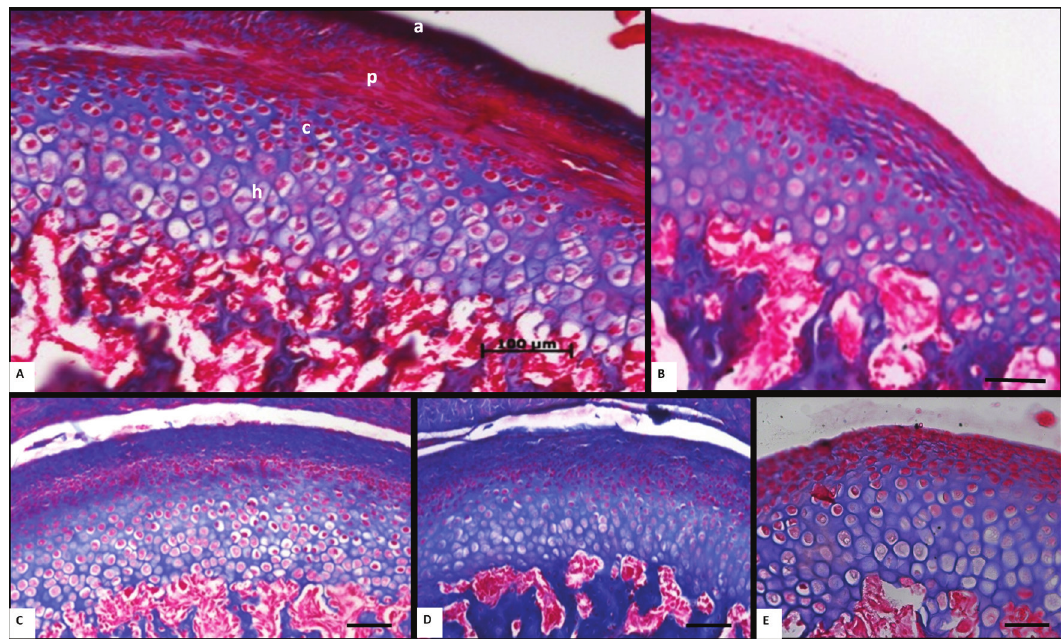
Figure 5- Light microscopy of the mandible condylar process cartilage (CP) of Wistar rats. Azo-carmine staining. A: group N, nourished from day 21 to day 60, with CP layers: articular (a), pre-chondroblastic (p), chondroblastic (c) and hypertrophic (h); B: group U, undernourished from day 21 to day 60; C: group R, renourished from day 21 to day 60; D: group